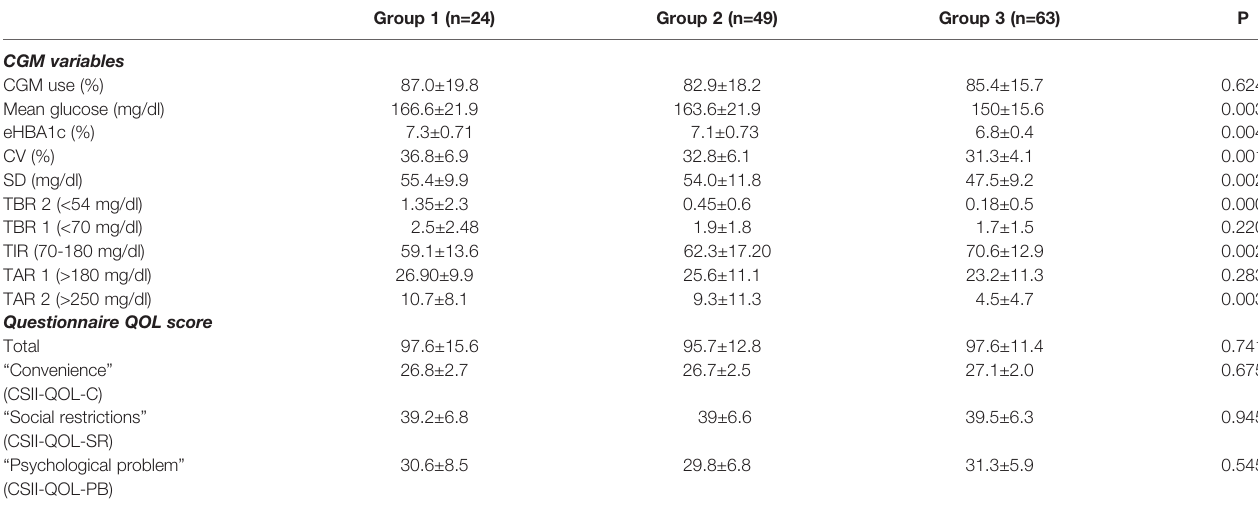
TABLE 3 | Overall CGM variables and Quality of Life questionnaire